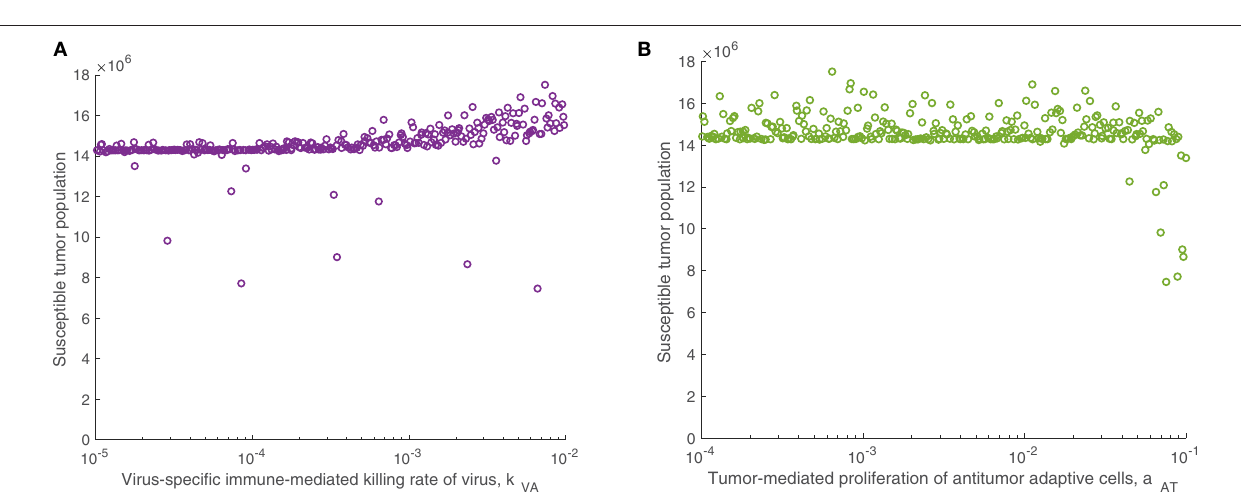
FIGURE 5 | Tumor size in adaptive immune sensitivity analysis. The tumor size is shown (A) as a function of k VA , the killing rate of the virus by virus-specific adaptive immune cells, and (B) as a function of a AT , the tumor-mediated proliferation of tumor-specific adaptive immune cells. We use t = 300 h as the endpoint for the adaptive sensitivity analysis. The partial rank correlation coefficient (PRCC) between k VA and the susceptible tumor population is P ( k VA ,300) = 0.7961, and between a AT and the susceptible tumor population is P ( a AT ,300) = −